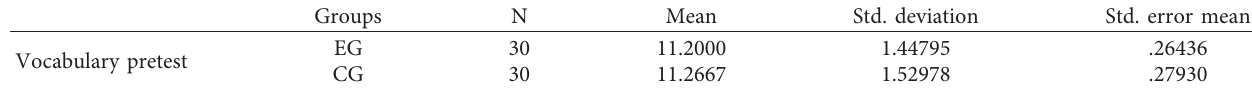
Table 1: Descriptive statistics (both groups’ pretest).